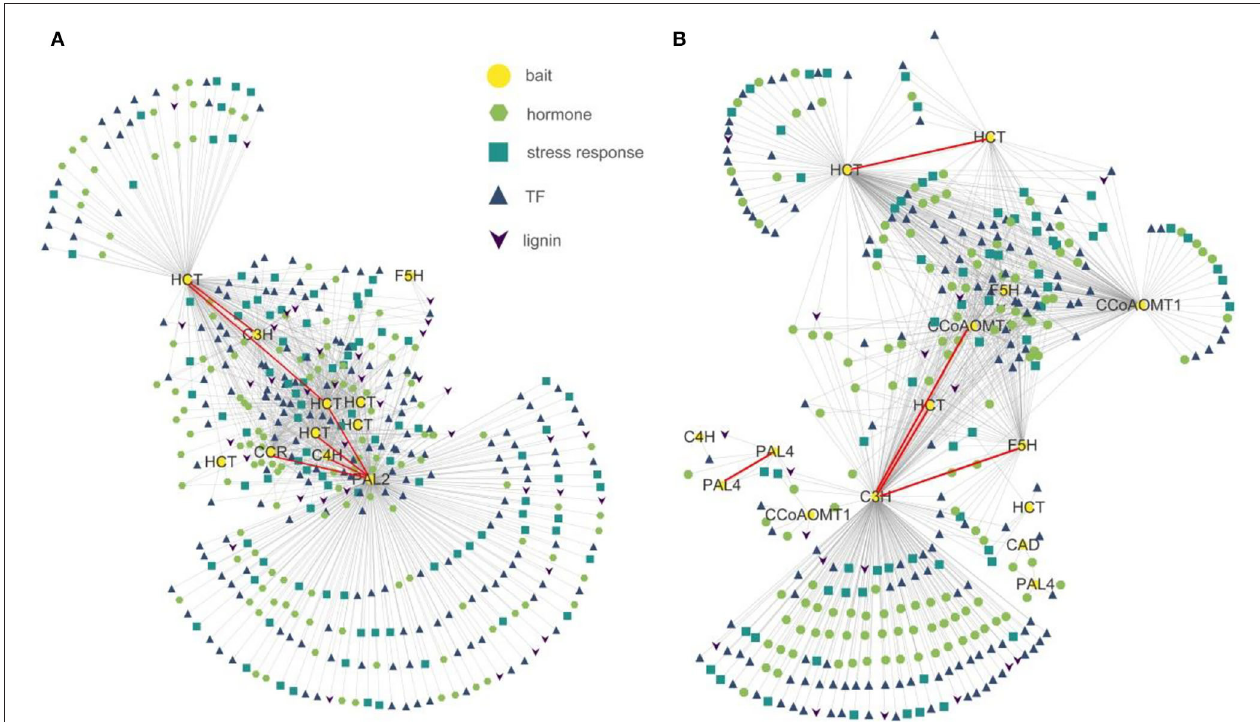
FIGURE 5 | Co-expression networks showing the relationships of lignin biosynthesis genes having differential expression in resistant ( P. flaviflorum ) and susceptible ( P. nigrum ) species of Piper with transcription factor, phytohormone response, and stress response genes. (A) Network for P. flaviflorum. (B) Network for P. nigrum